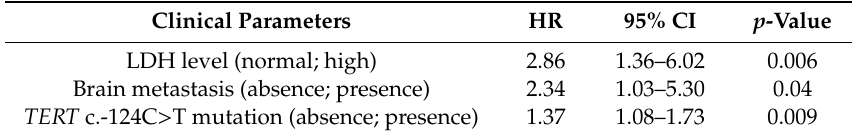
Table 3. Multivariate analysis of clinical parameters and TERT c.-124C > T mutational status with regard to PFS in BRAF V600 patients.